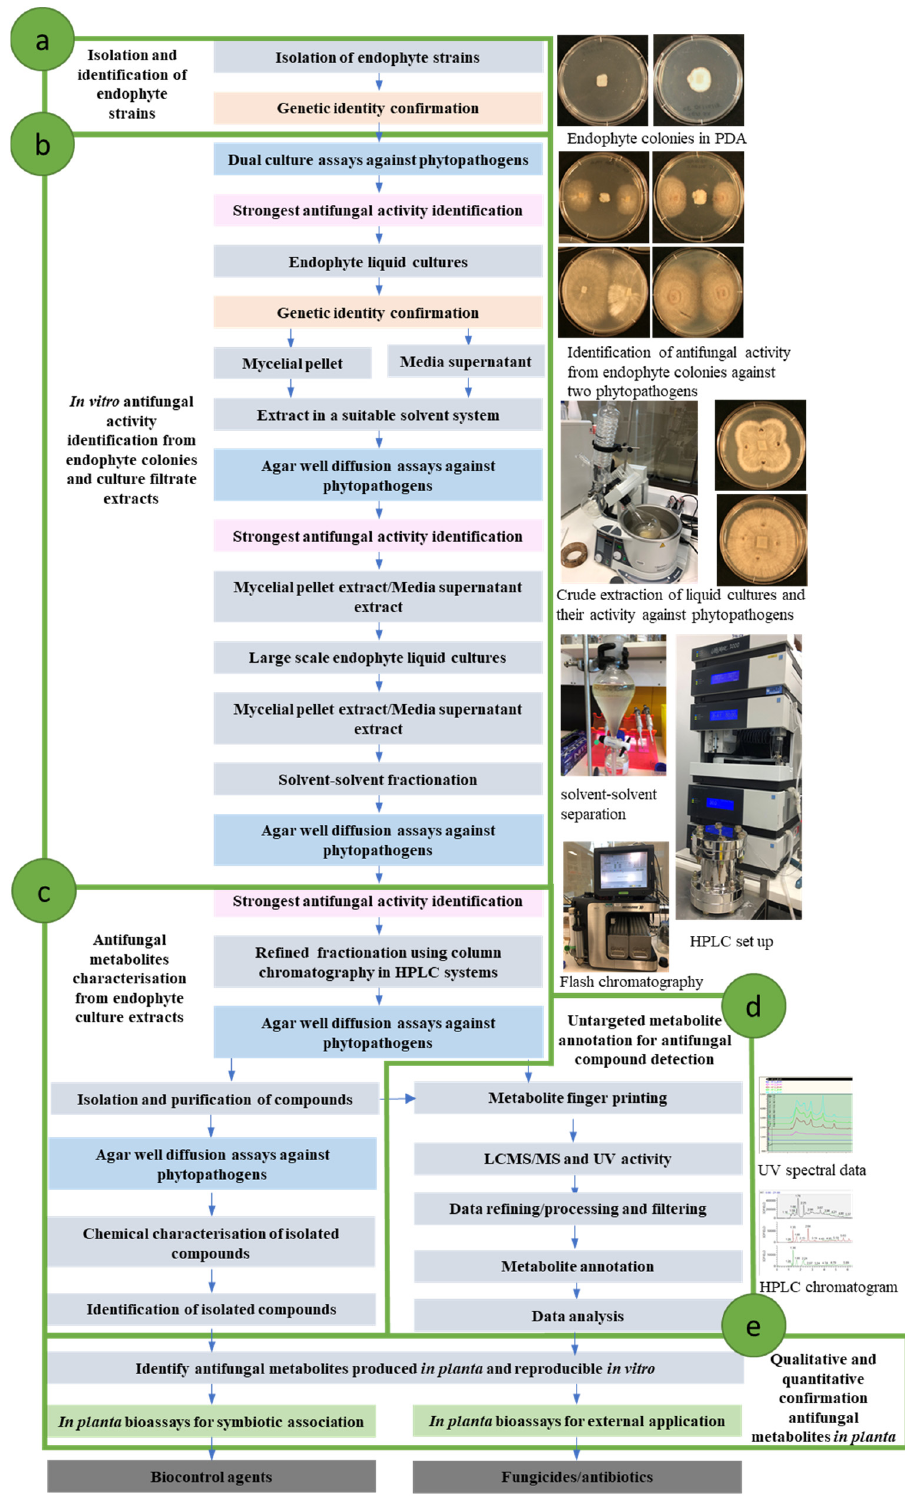
Figure 2. An experimental workflow proposed for bioprospecting antifungal metabolites from Epichloë endophytes using a stepwise process. ( a ) Epichloë strain identification, ( b ) Identification of bioactive strains using in vitro antifungal activity assays, ( c ) antifungal metabolite isolation and char- acterisation, ( d ) untargeted metabolite annotation for antifungal compound detection, ( e ) qualitative and quantitative confirmation of antifungal metabolites in